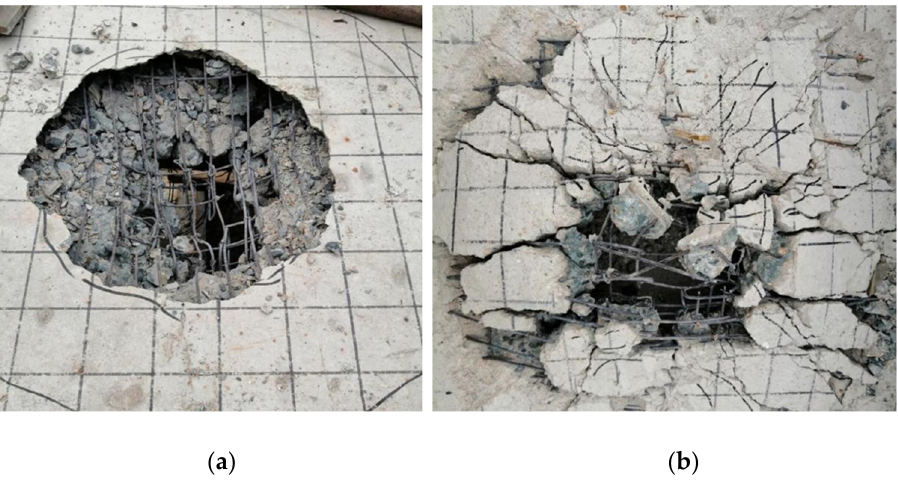
Figure 8. Fatigue test failure of PL1 test beam ( a ) Damage to upper part of bridge deck and ( b ) Damage to lower part of bridge deck.